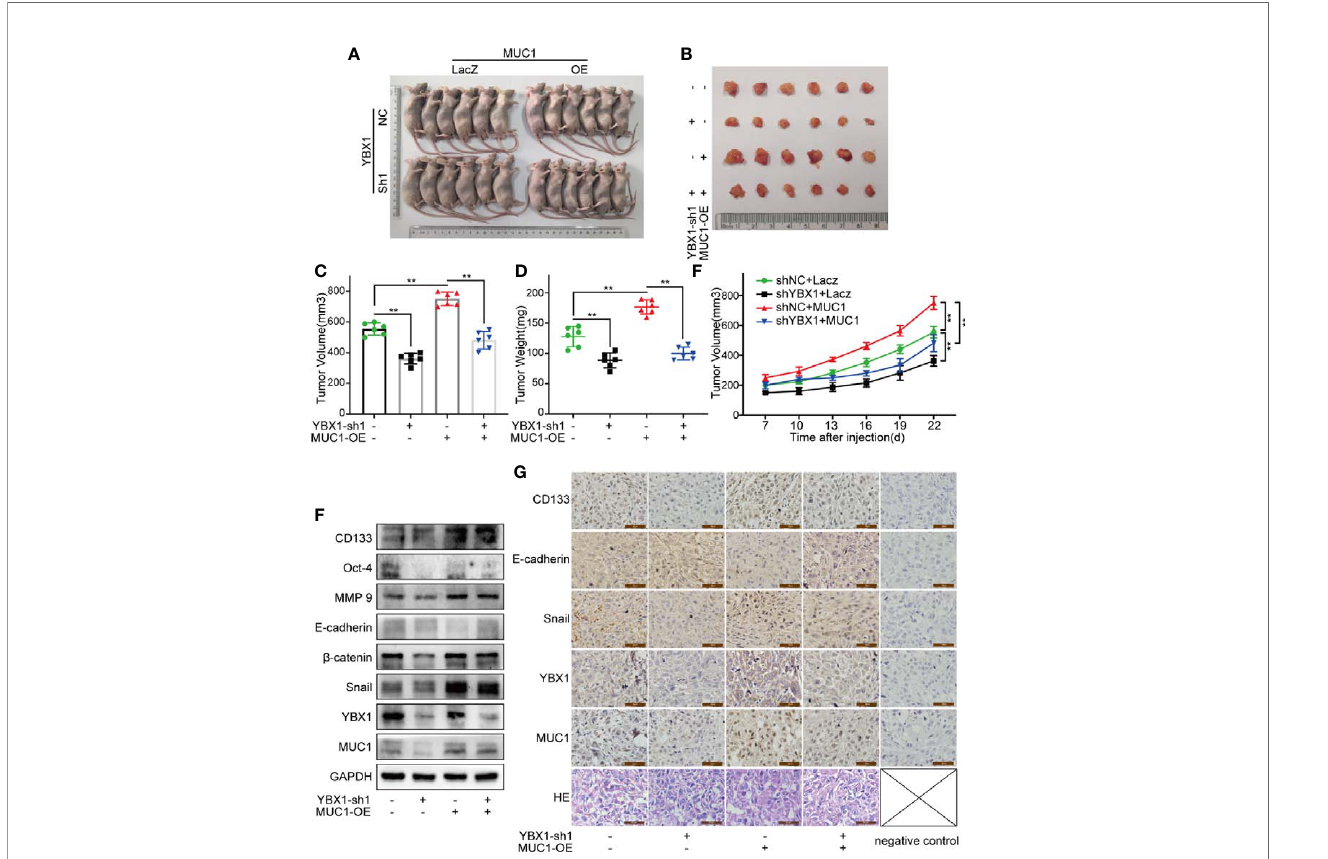
FIGURE 5 | YBX1 promotes tumor growth by upregulating MUC1 in human lung cancer xenograft mouse models. (A) The morphology of all mice participating in the experiment was photographed. (B) The morphology of tumor xenografts from all mice was photographed. (C, D) The tumor volume and weight from the different groups were measured. (E) The tumor volume of each mouse was measured at a regular interval of 3 days after 7 days of injection. (F) The expression of YBX1, MUC1, CD133, Oct-4, MMP9, E-cadherin, b -catenin, and Snail within xenografts in the different groups were detected by Western blot. (G) The expression of YBX1, MUC1, CD133, E-cadherin, and Snail in tumor tissues was detected by IHC staining. The xenograft tissue morphology showed by HE staining. Scale bars= 50 m m. The level of signi fi cance was indicated by **P <